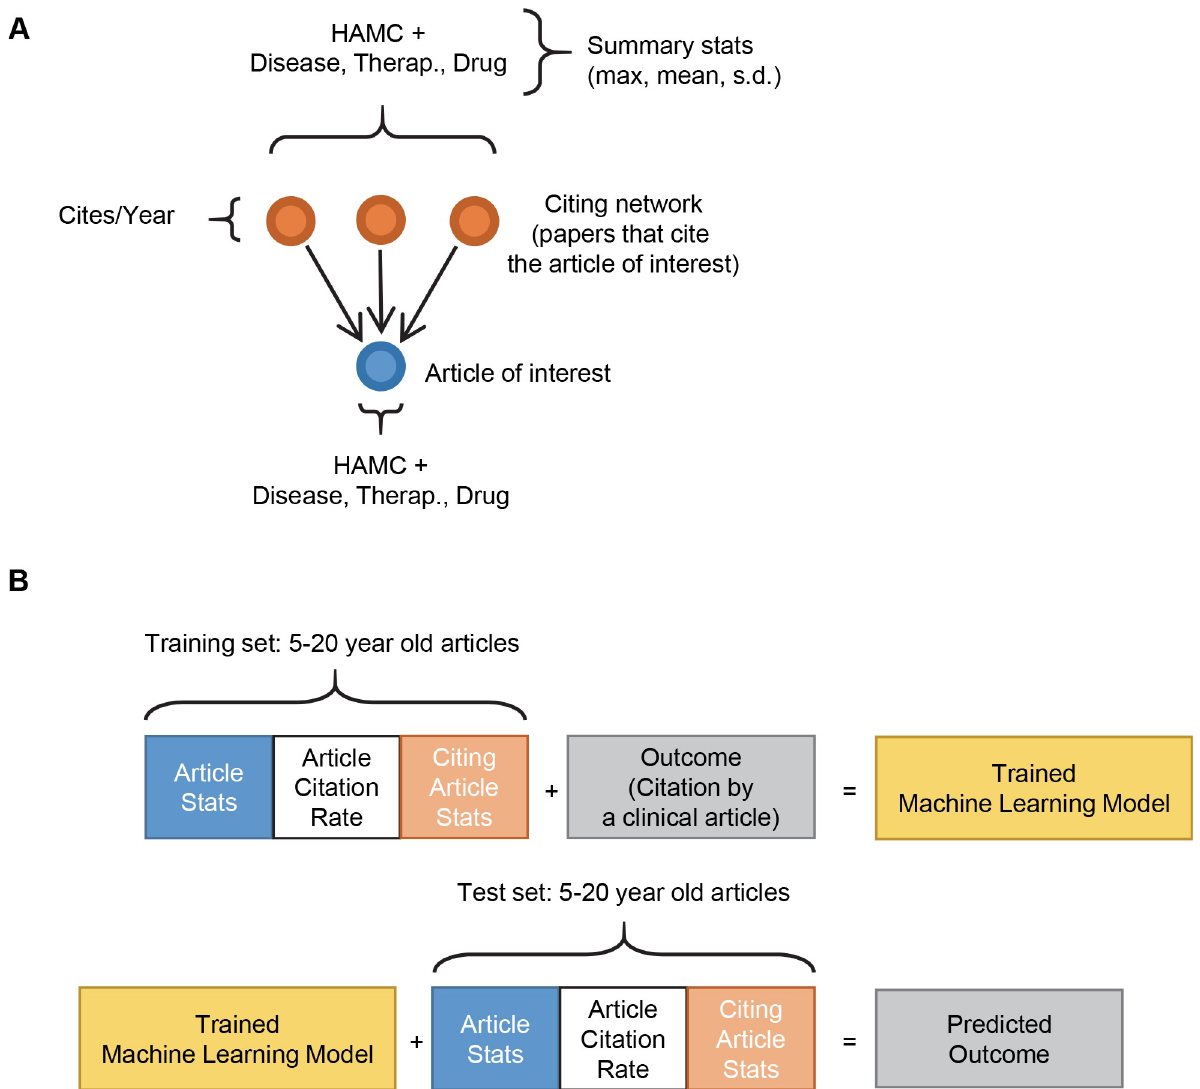
Fig 2. Training a machine learning system to predict future translation. (A) Schematic of inputs into the machine learning system. Papers were assigned the same HAMC scores used for visualization on the trilinear graphs, as well as 3 binary indicators, one each for the presence of modifying MeSH terms in either the Disease, Therapeutic/Diagnostic Approaches, or Chemical/Drug categories. These properties were also scored for papers citing the article of interest, and the citing network was summarized by the max, mean, and standard deviations (SDs), as well as the overall citation rate (cites/year). For this analysis, citation rate is preferable to RCR [18], because citations per year can be used immediately while a meaningful citation count must accrue before RCR can be calculated. (B) Schema for training the machine learning model and generating predictions. HAMC, Human, Animal, and Molecular/Cellular; max, maximum; MeSH, Medical Subject Headings; RCR, Relative Citation Ratio.